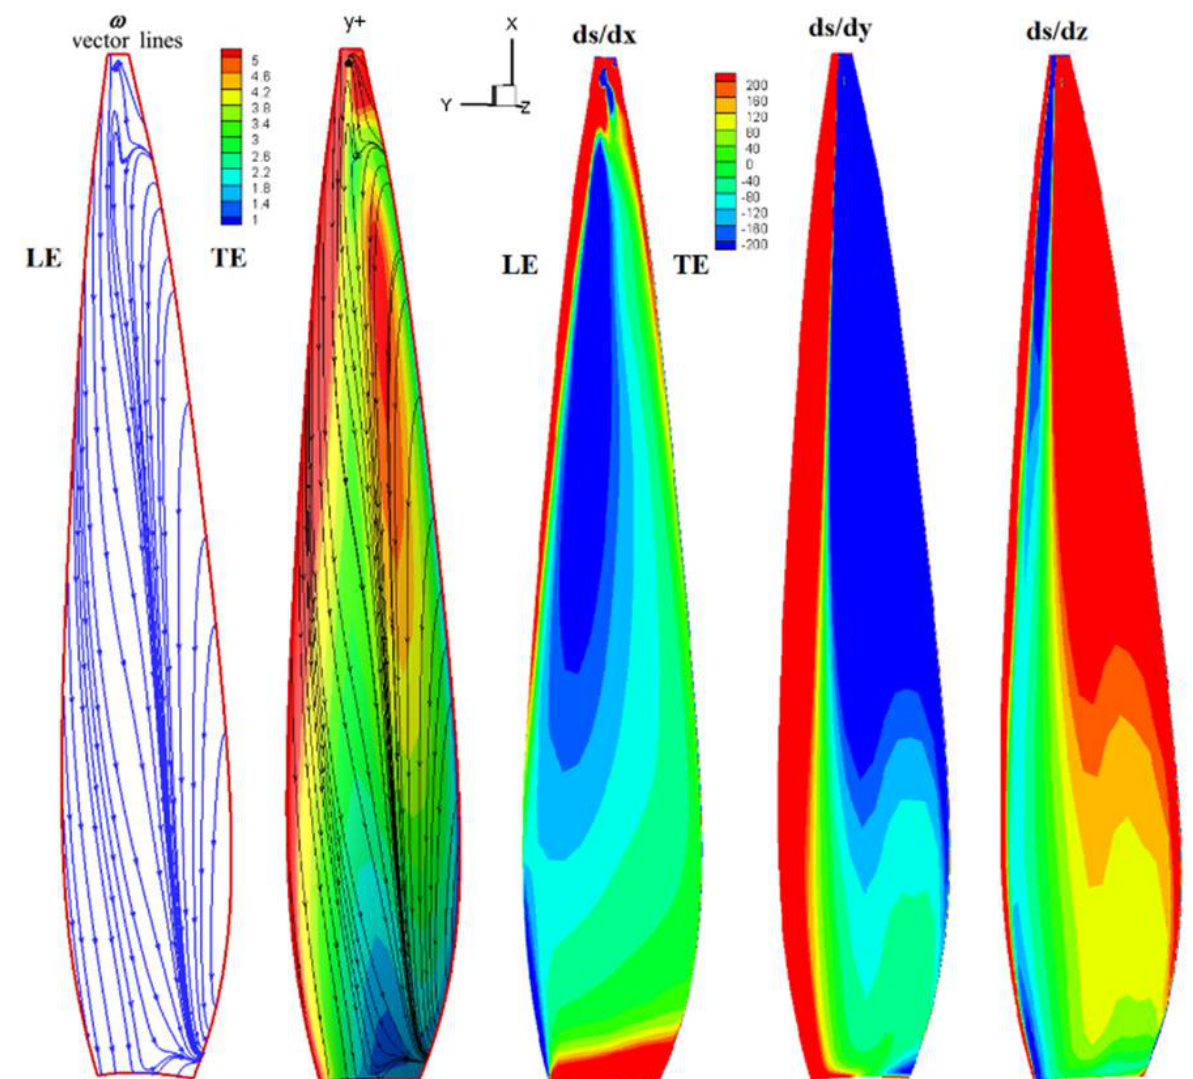
Figure 21. Radial vorticity, boundary vorticity flux and other related properties on blade wall of the solo propeller ( 3X-40R domain) suction side to show the connection between entropy production and vorticity flux.